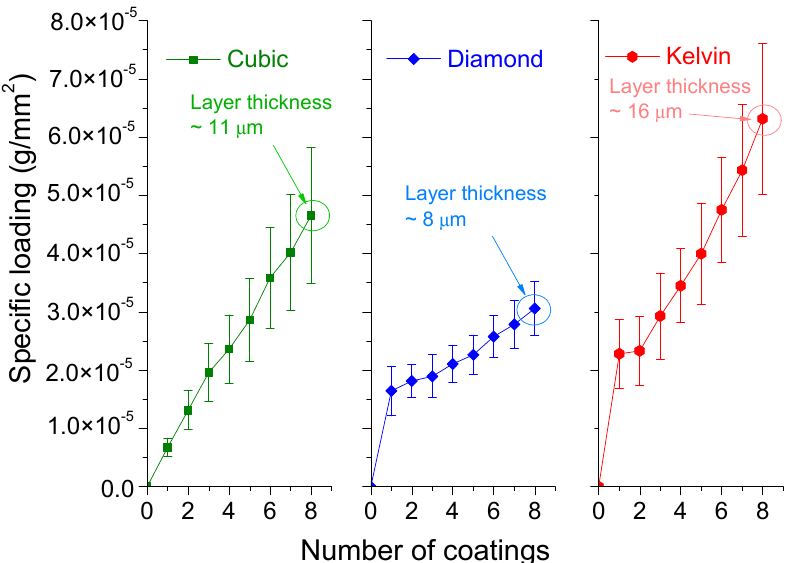
Figure 8. Weight gain of Al 2 O 3 per coating of the printed POCS with normalized exposed area ~2400 mm 2.